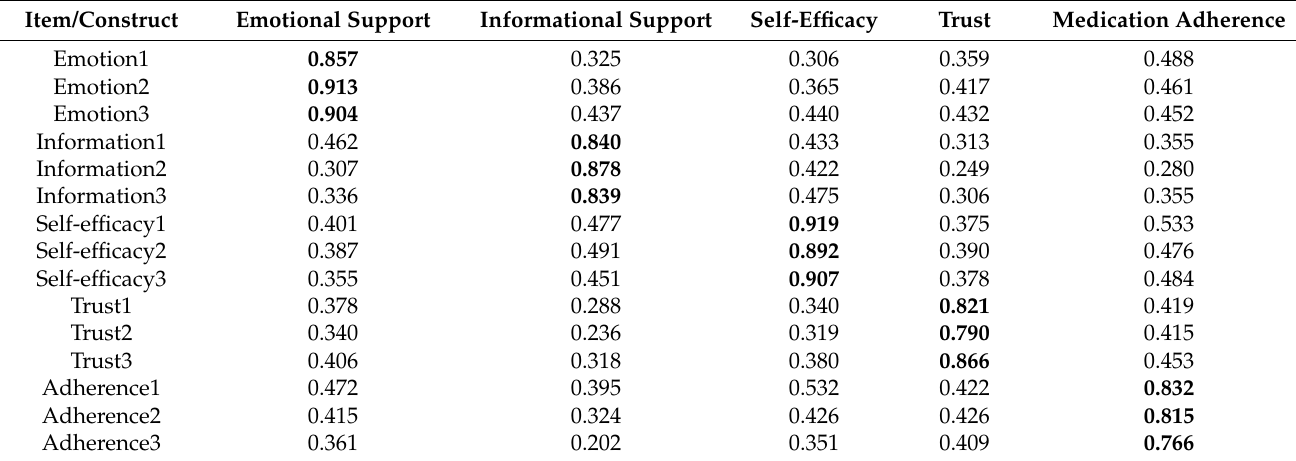
Table 2. Cross loading.